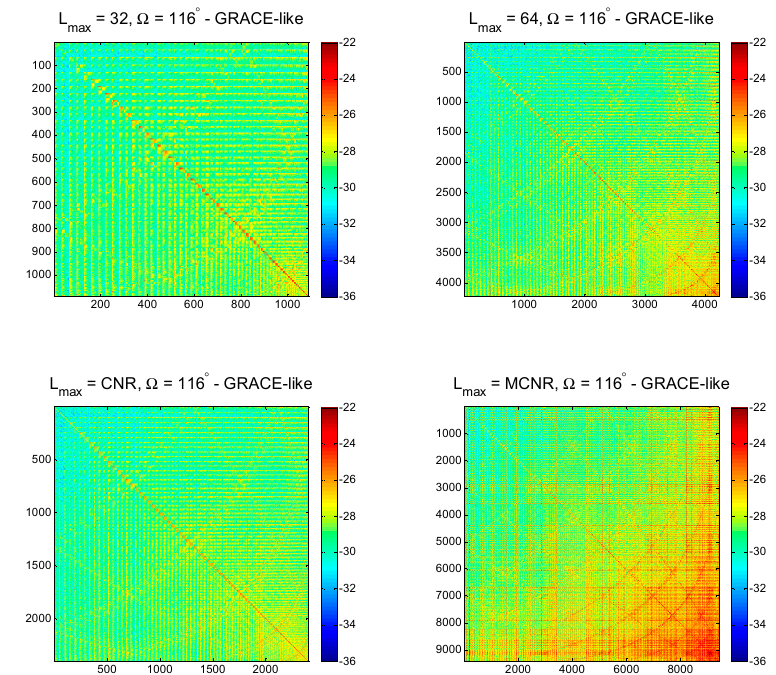
Figure 16. Covariance matrices of 6-day solutions of the scenario (a) inline formation for Ω = 116°. Top left : L max = 32, top right : L max = 64, bottom left : L max = CNR, and bottom right : L max = MCNR. Pendulum Formation